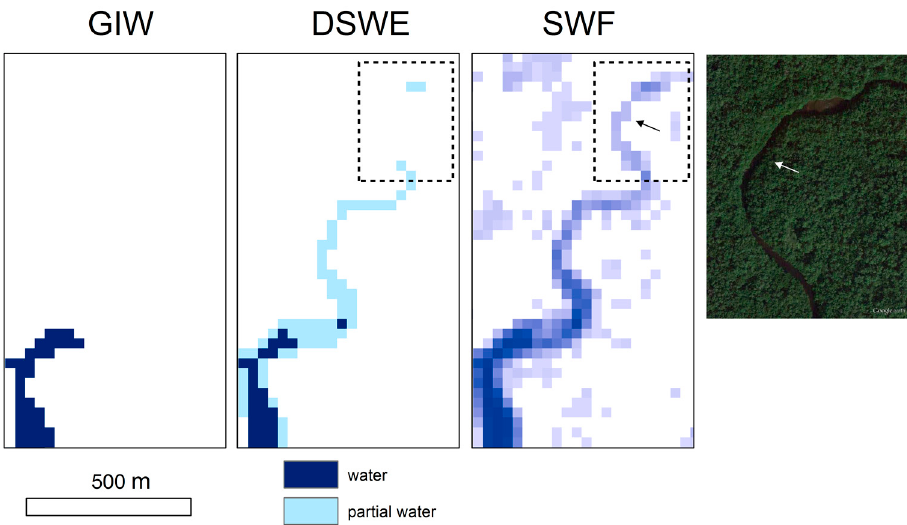
Figure 9. Representation of a small forested stream using the Global Inland Water product [18], DSWE and SWF. The zoomed area shown in the GoogleEarth screenshot is shown as a dotted rectangle. The SWF value at the arrow is 0.1, where the width of the visible portion of the river was estimated to be 5 m from the GoogleEarth imagery.